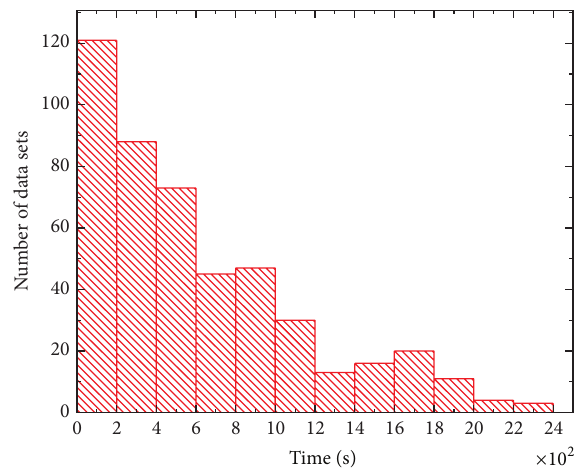
Figure 1: Histogram of the time span of the studied data